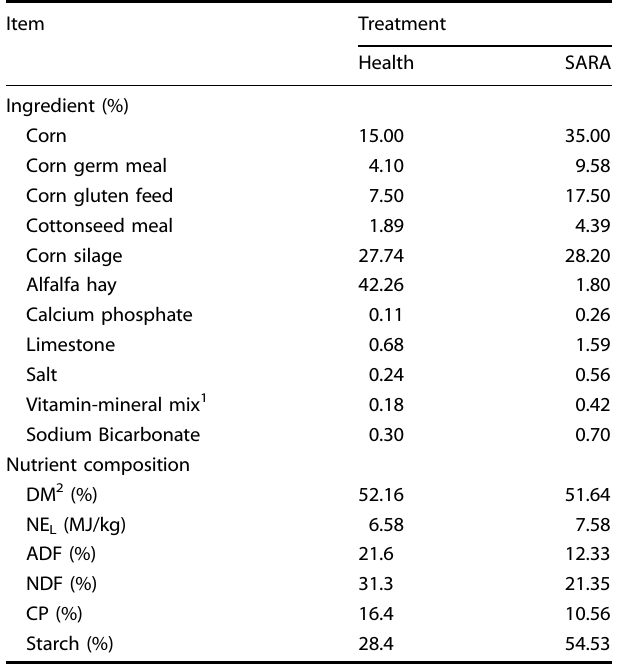
Table 1. Ingredients and nutrient composition of the healthy and SARA groups on a dry matter (DM)